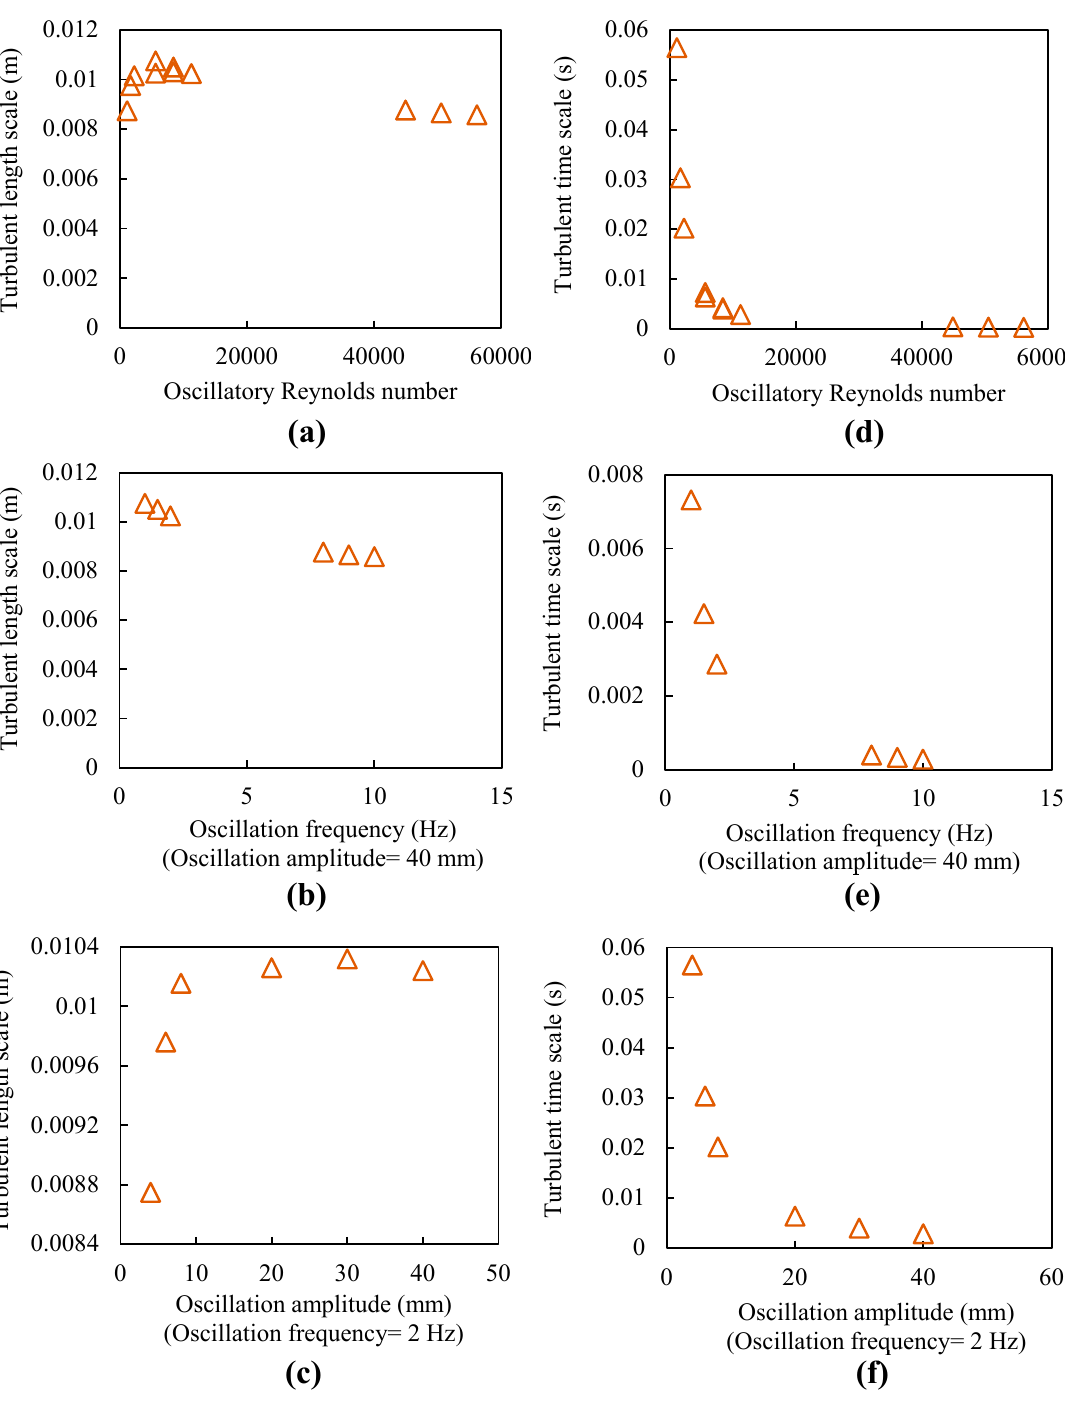
Figure 7. Turbulent length scale versus ( a ) oscillatory Reynolds number, ( b ) oscillation frequency, and ( c ) oscillation amplitude and turbulent time scale versus, ( d ) oscillatory Reynolds number, ( e ) oscillation frequency, and ( f ) oscillation amplitude.